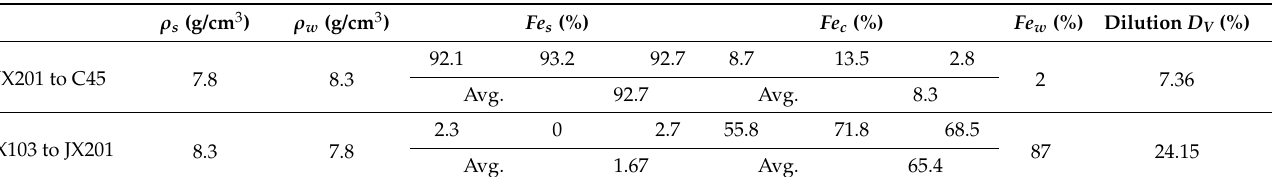
Table 2. Dilution calculation of the two boundaries.